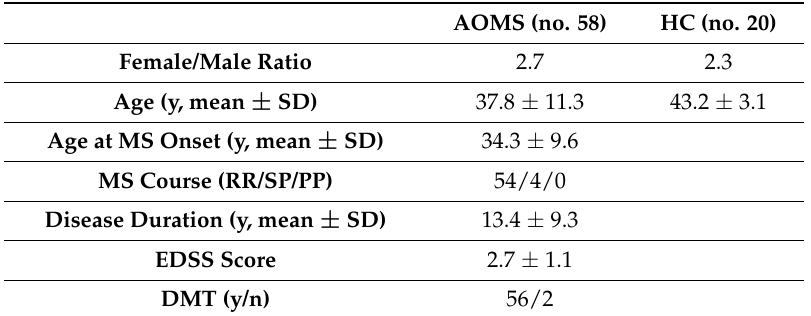
Table 1. Summary of the demographic and clinical features of the study